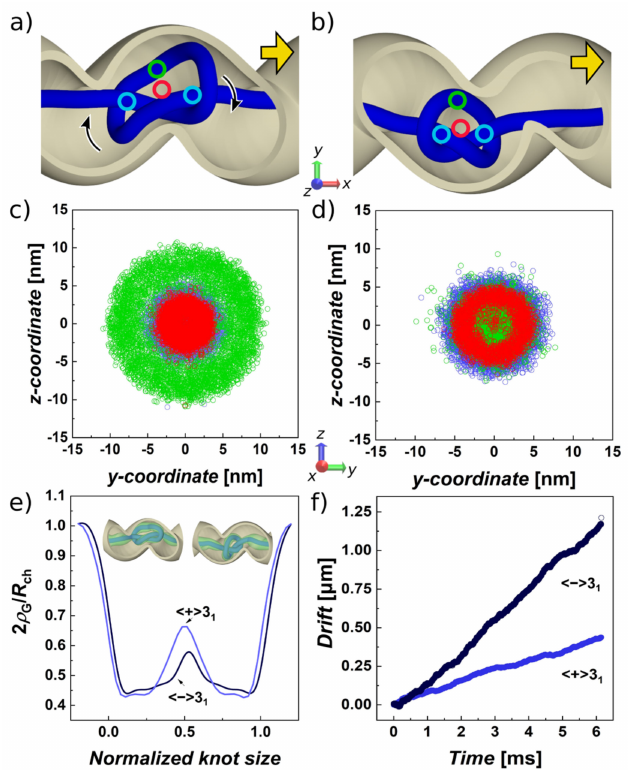
Figure 2. Trefoil knot in helical confinement. ( a ) A snapshot of trefoil with positive writhe <+>3 1 in a channel with negatively oriented helicity representing an antichiral configuration. The blue circles indicate start and end bead of the knot detected by KymoKnot and Knoto-ID, the green circle indicates the middle bead of the knot, and the red circle is the center of mass of the knot. The yellow arrows indicate the direction of external pulling force for the particular snapshot. ( b ) Equichiral system of a trefoil with a negative writhe < − >3 1 in a channel with negative helicity ( c , d ) distribution of the knot starts and ends middle points and center of masses of the knot. ( e ) Global radius of curvature (GRC) ρ G compared to radius of the channel R ch = 1.5 σ along the size of the knot; in the insets, the GRC is shown in green transparent color. ( f ) Total drift of the knot ∆ x along the polymer as a function of time compared for the equichiral and antichiral